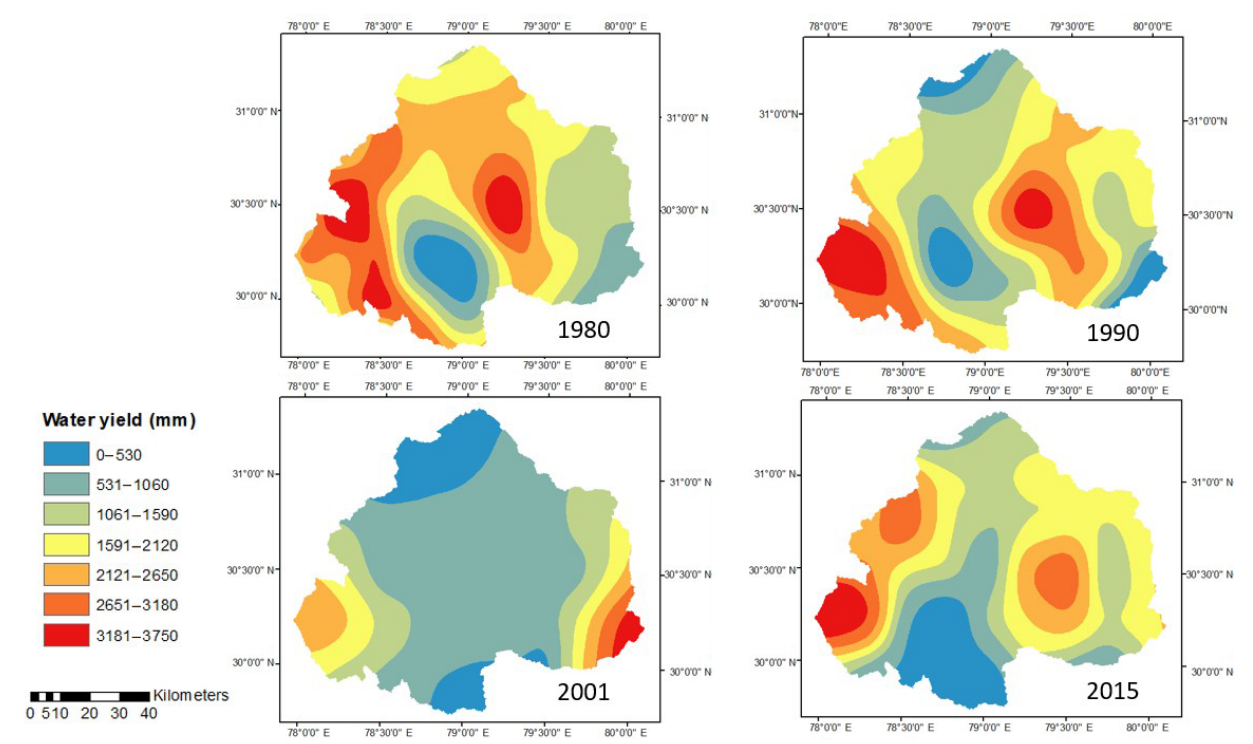
Figure 6. Water yield obtained by computing pixel-wise value of parameter w from Xu et al.